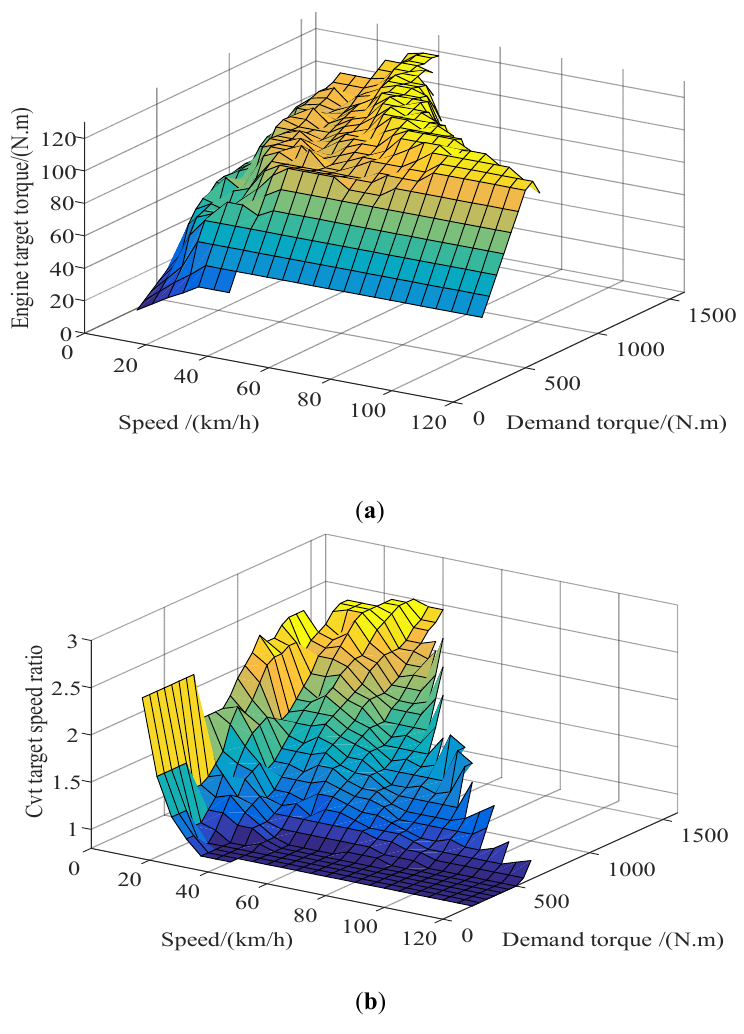
Figure 9. Optimization results in the engine mode: ( a ) target torque of engine; ( b ) target speed ratio of CVT.